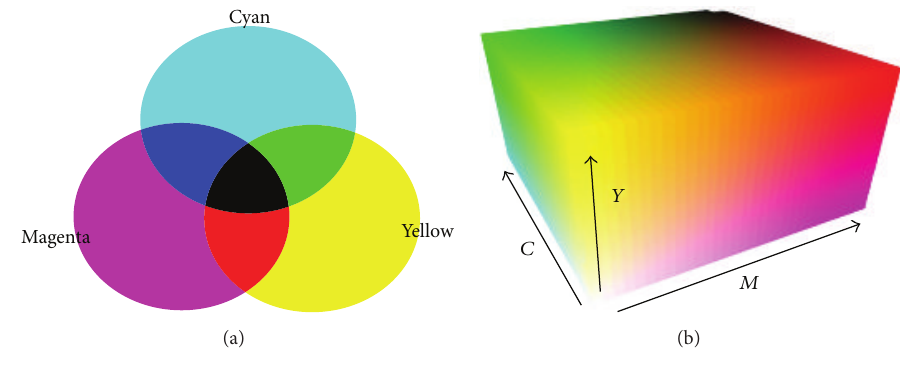
Figure 1: (a) Subtractive CMY model; (b) CMY color